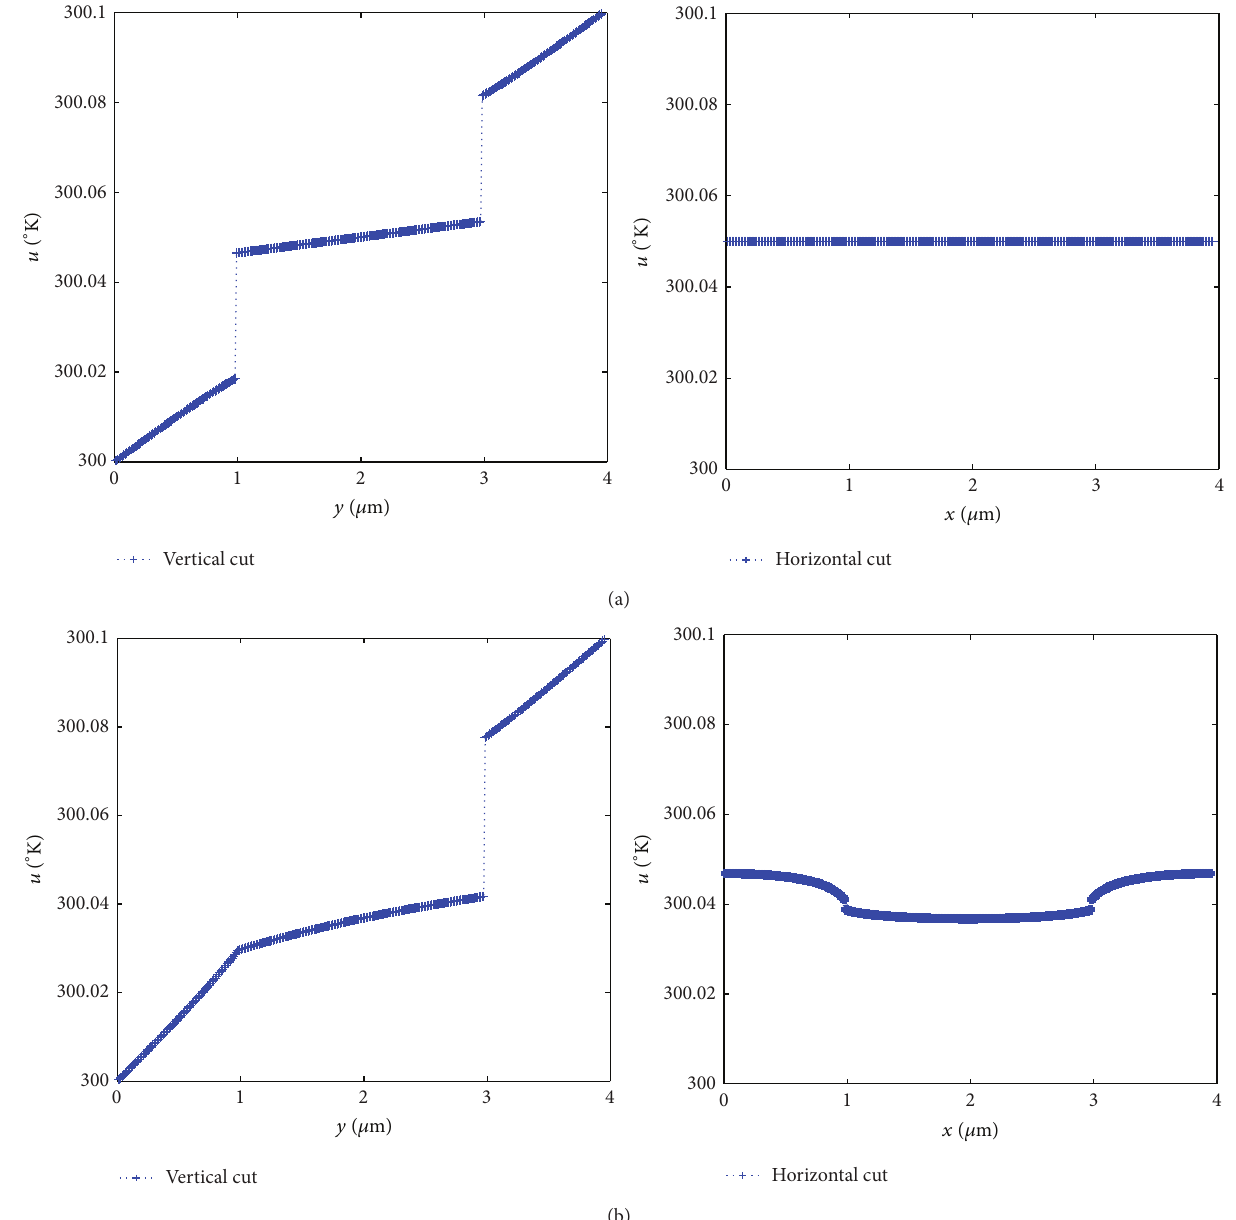
Figure 4: Distribution of temperature following the vertical and horizontal cuts at the center of circular inclusion: (a) double partial debonding; (b) single partial